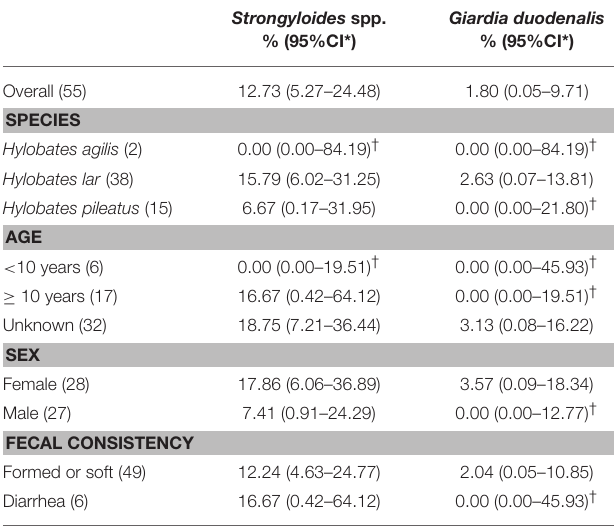
TABLE 1 | Prevalence of intestinal parasitic infection by gibbon species, age, sex, and fecal